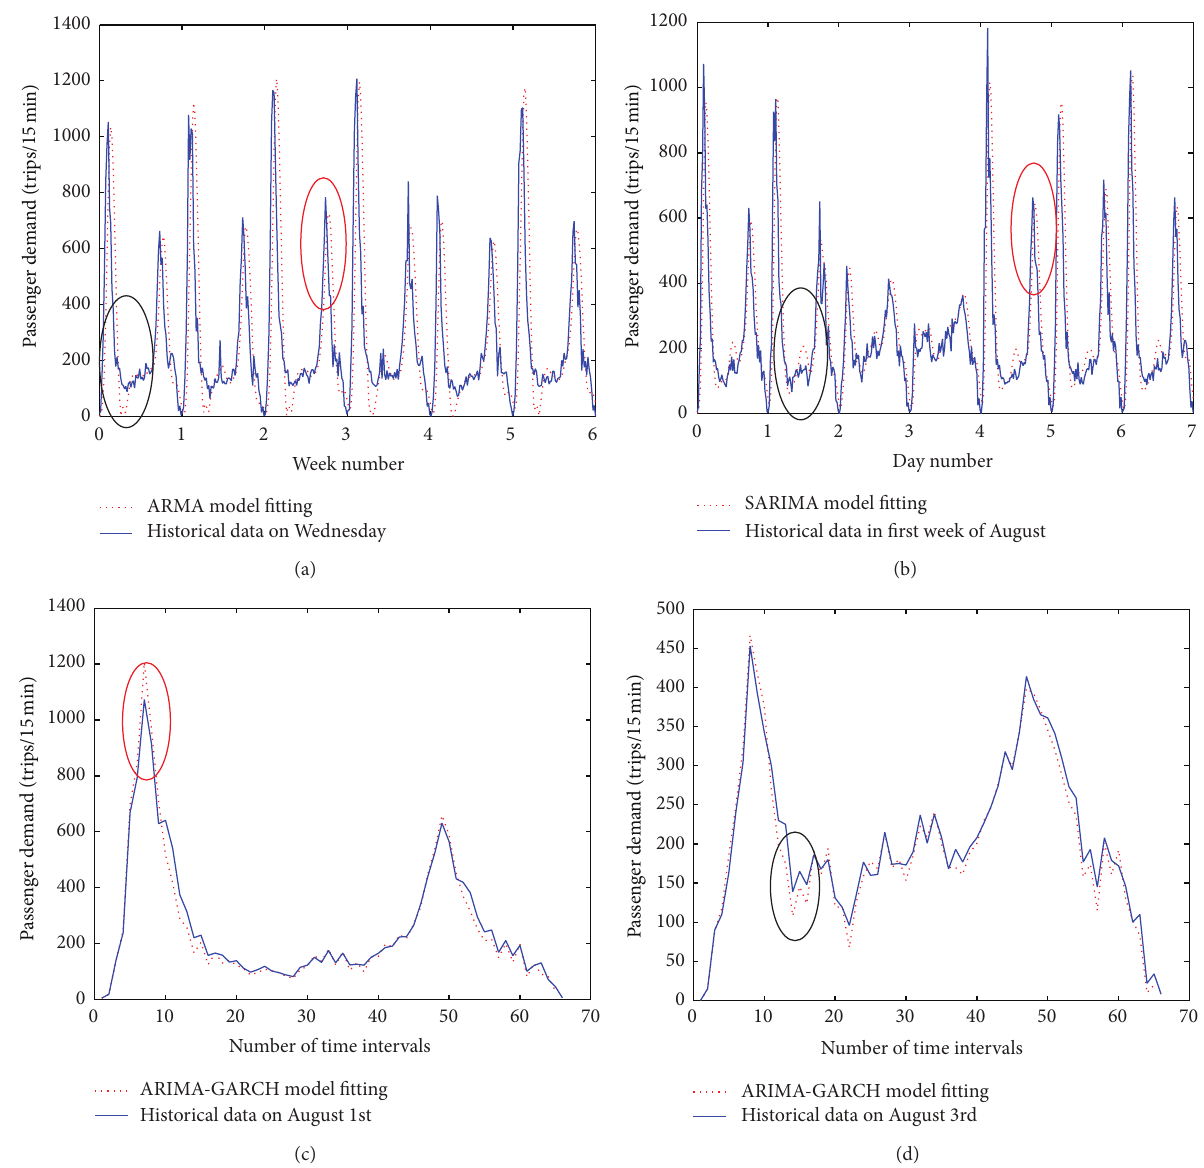
Figure 2: Fitting results of weekly, daily, and 15min model, (a) fitting result of ARMA model, (b) fitting result of SARIMA model, (c) fitting result of ARIMA-GARCH model on weekday, and (d) fitting result of ARIMA-GARCH model on weekend.